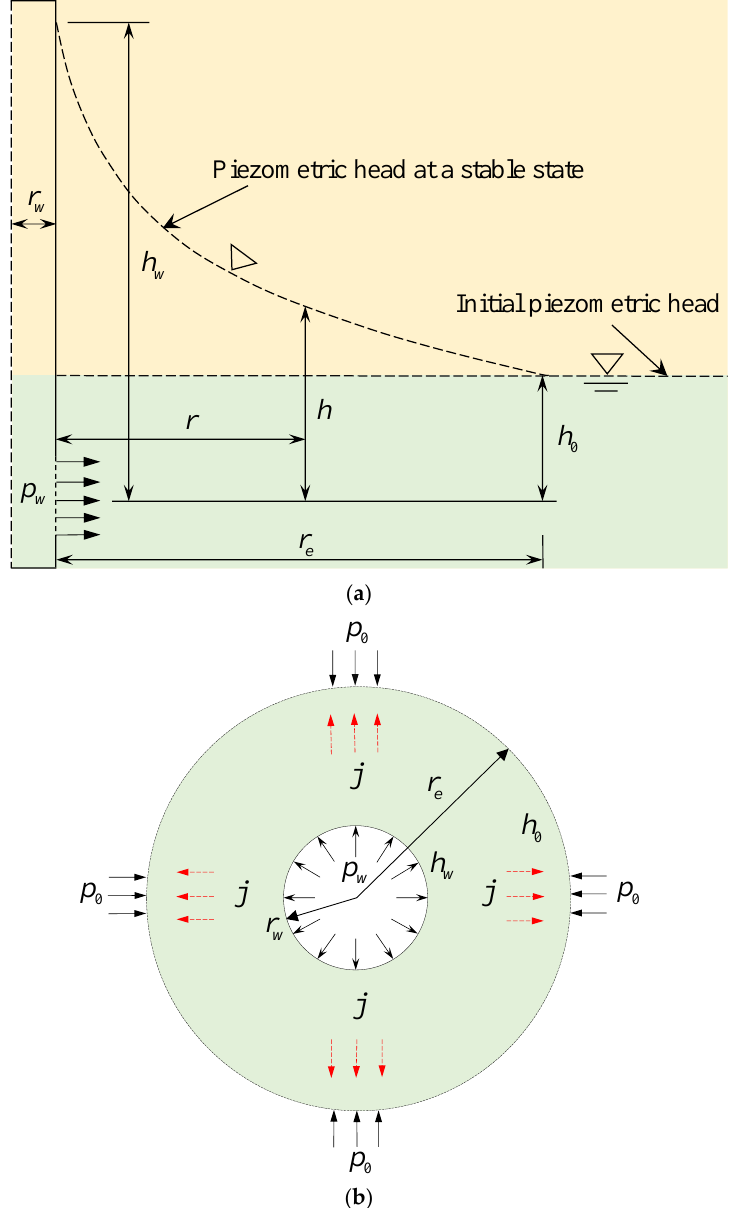
Figure 1. Schematic diagrams of ( a ) hydraulic head distribution around the wellbore for hydraulic fracturing and ( b ) a cross-section.